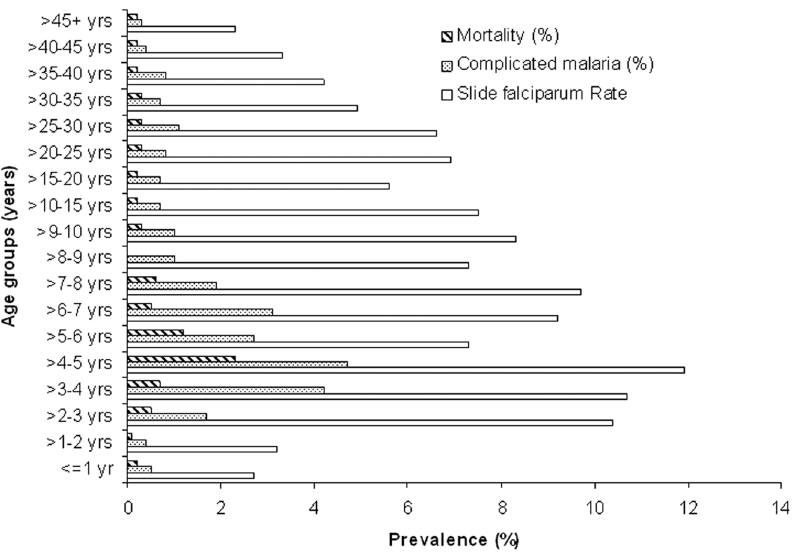
Fig. 2. Age wise P. falciparum malaria, complicated malaria and associated mortality in a tertiary care hospital in Bastar, Chhattisgarh, Central India. The age group interval is kept one year for children up to 10 years of age. For older children and adults age group interval is five